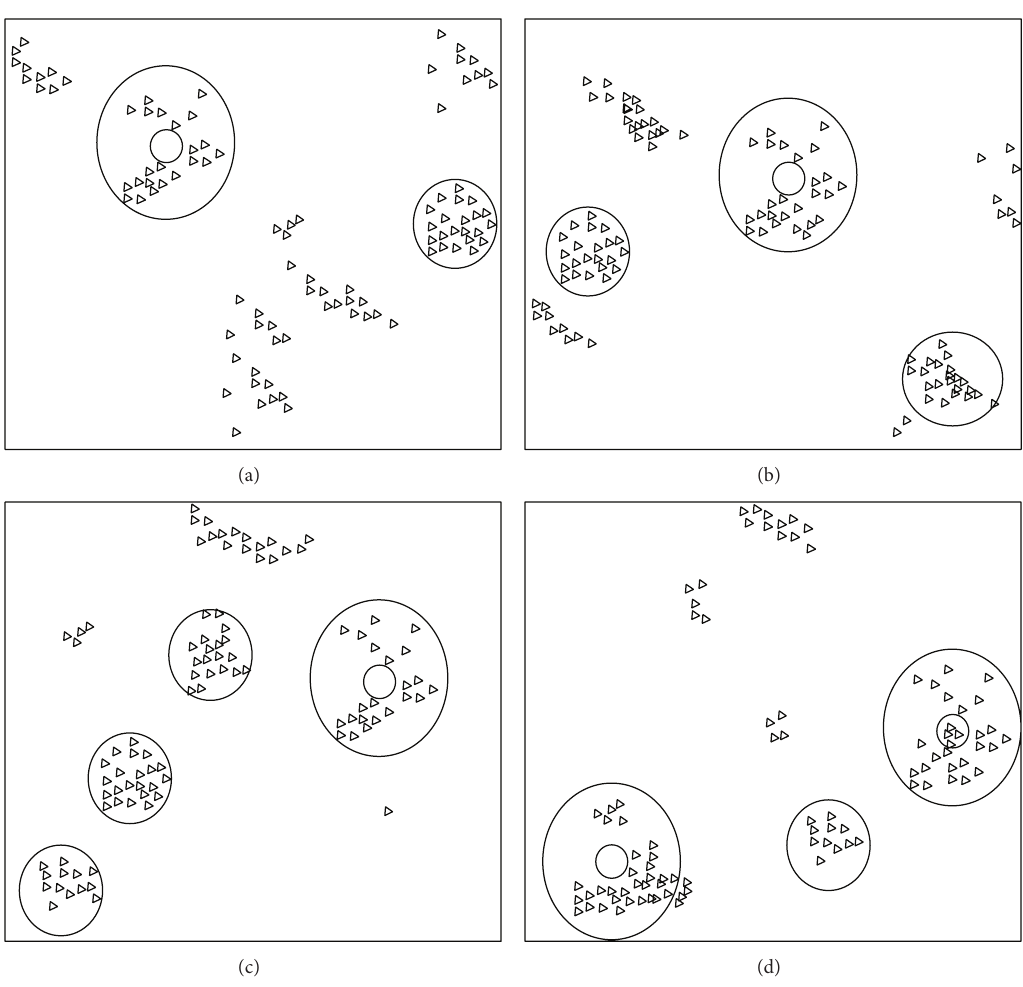
Figure 17: Circular and doughnut formations. Position of entities at ticks (a) 0, (b) 400, (c) 800, and (d) 1200. Table 7: Circular and doughnut formations: results of the experi- ments in NetLogo. Andersson’s Circular Doughnut